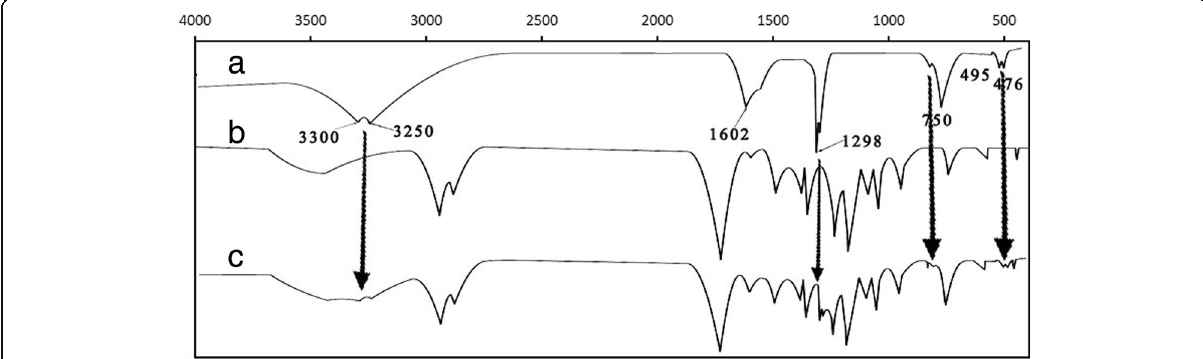
Fig. 4 FT-IR curve. a Cis -DIDP powders. b PCL fibers. c Cis -DIDP@PCL